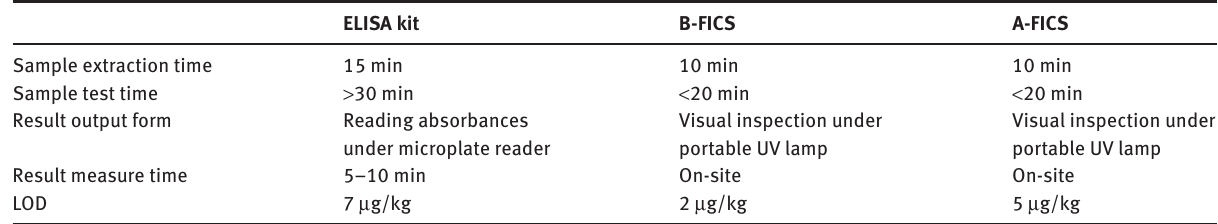
Table 3: Comparison of the analytical performance of the Au nanocomposite-based fluorescent quenching immunochromatographic sensor (B-FICS), gold nanoparticles-based fluorescence quenching immunochromatographic sensor (A-FICS) with the commercial ELISA kit in cereal